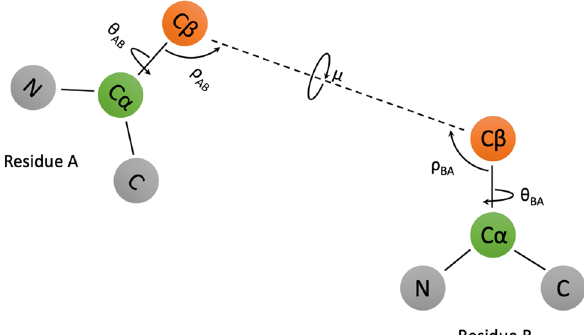
Figure 2. Orientation angles. The three orientation angles mu(μ), theta(θ) and rho(ρ) between any pair of residues in a protein. In the 3D structure of the protein, considering any two residues A and B, θ AB represents the dihedral angle between the vectors N A —> Cα A and Cβ A —> Cβ B along the axis of Cα A —> Cβ A . ρ AB represents the angle between the vectors Cβ A —> Cα A and Cβ A —> Cβ B . θ and ρ depends on the order of residue and thus are asymmetric. μ represents the dihedral angle between the vectors Cα A —> Cβ A and Cβ A —> Cα B along the axis of Cβ A —> Cβ B . These orientation angles help in representing the direction of residue A to residue B and vice- versa. The orientation angles were originally described in Yang et al. 23 We used different notations of angles from them to prevent confusion with conventionally used angle